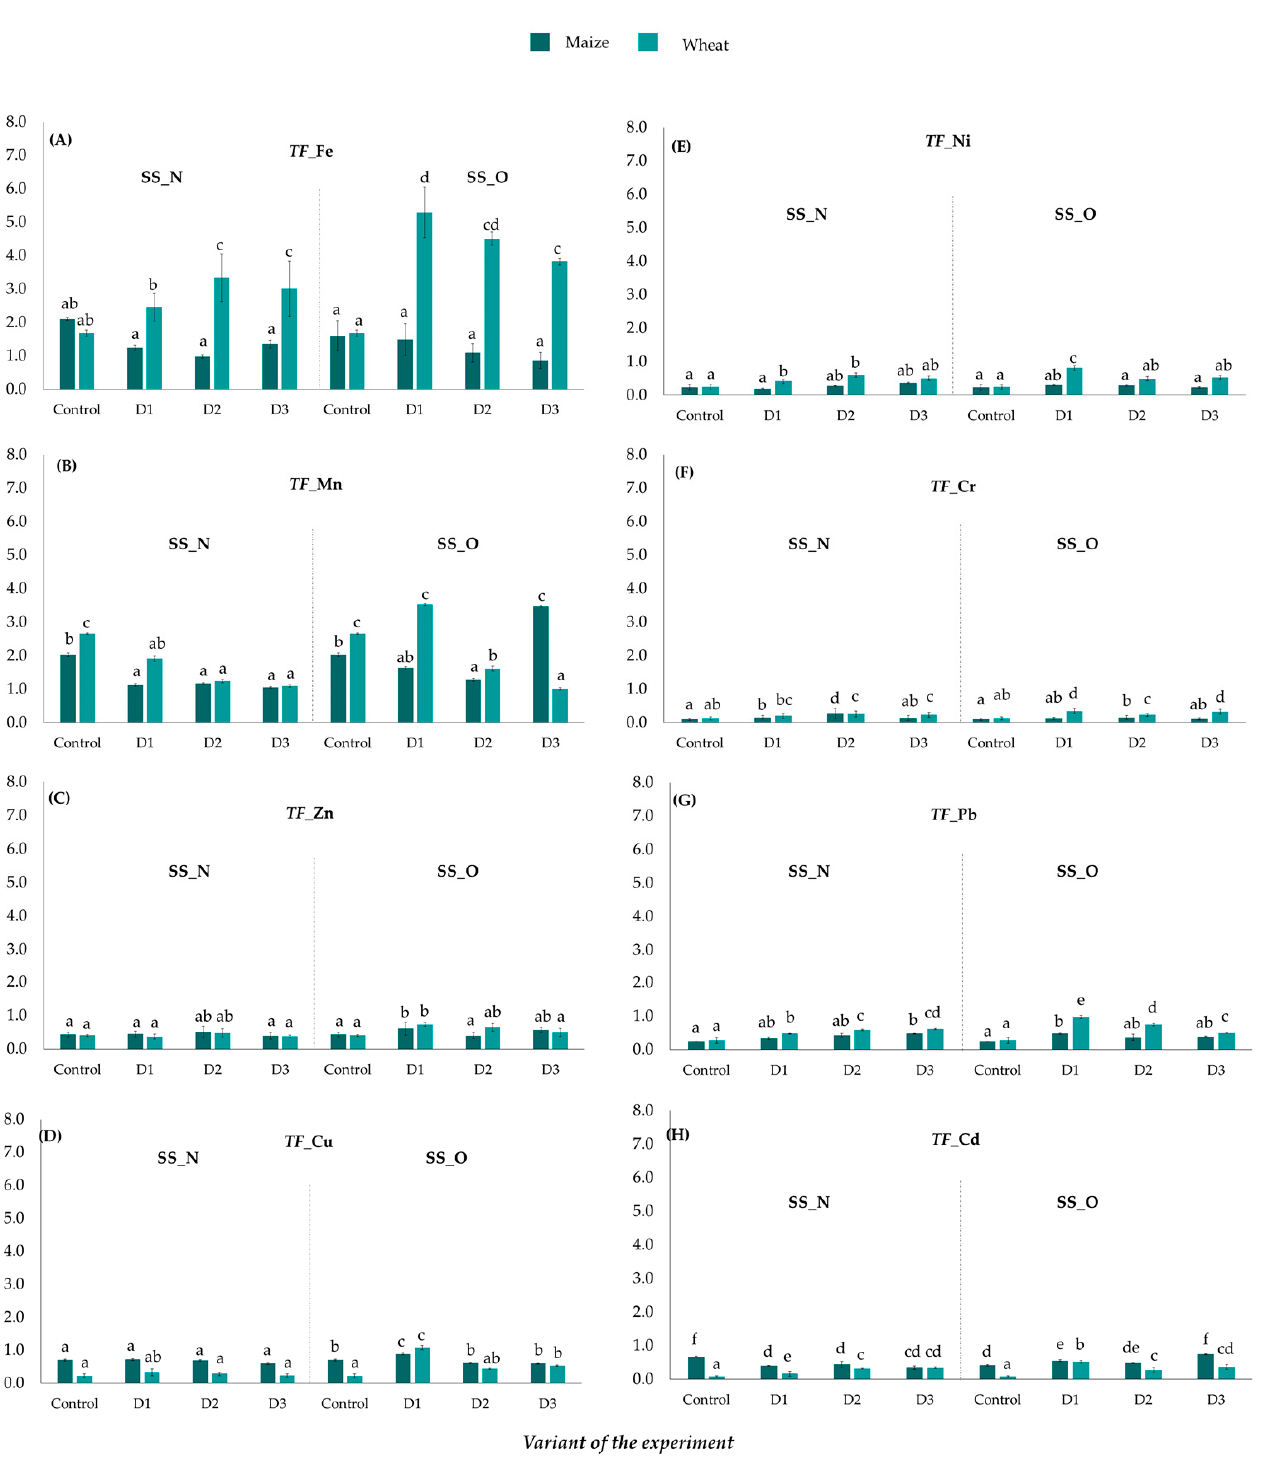
Figure 5. Translocation factors (TFs) of Fe ( A ), Mn ( B ), Zn ( C ), Cu ( D ), Ni ( E ), Cr ( F ), Pb ( G ), and Cd ( H ) in maize and wheat depending on the dose and type of sewage sludge used in the experiment. Mean values ( n = 9) ± standard error. Identical letters denote no significant ( p < 0.05) differences between the experimental objects according to the post hoc Tukey HSD test. Explanation: SS_N—non-ozonated sewage sludge; SS_O—ozonated sewage sludge; D1, D2, D3—dose of sewage sludge—3, 6, 9 Mg ha − 1 , respectively.